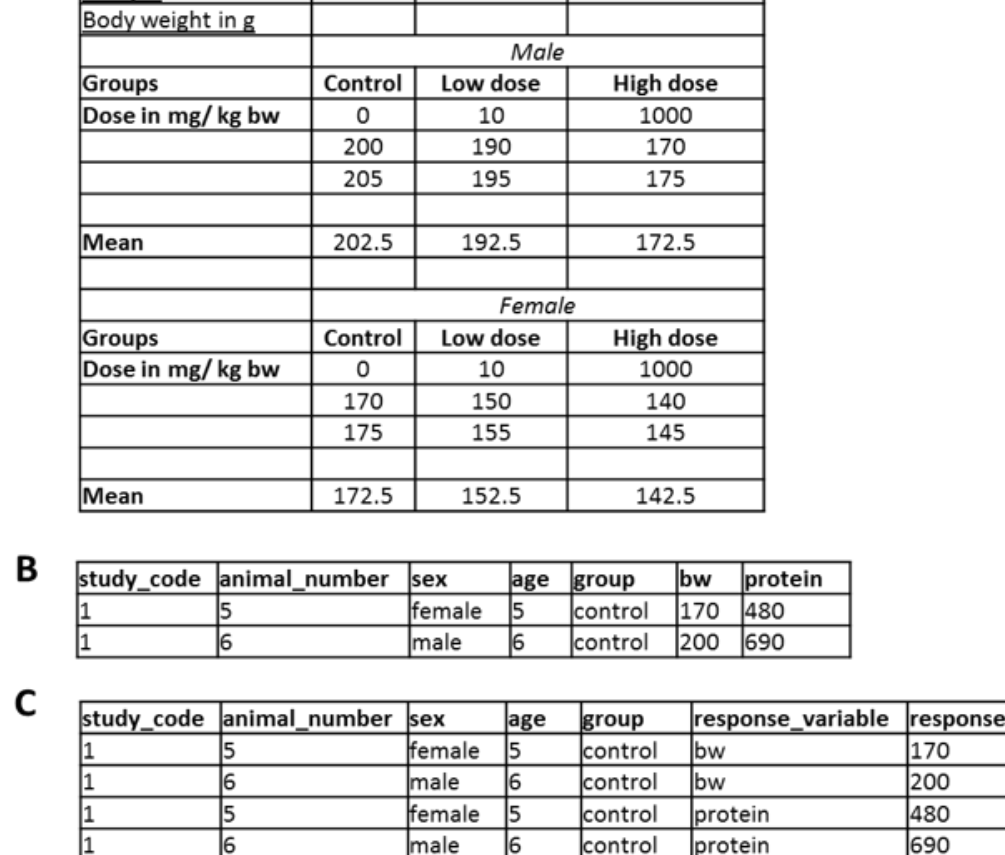
Figure 1: Data formats: While the format in ( A ) allows the comparison of groups, it is not useful for storing data. Preferred formats should be ( B ) or even more tidy ( C ), that are directly readable for most statistical programs and allow filtering in spreadsheet